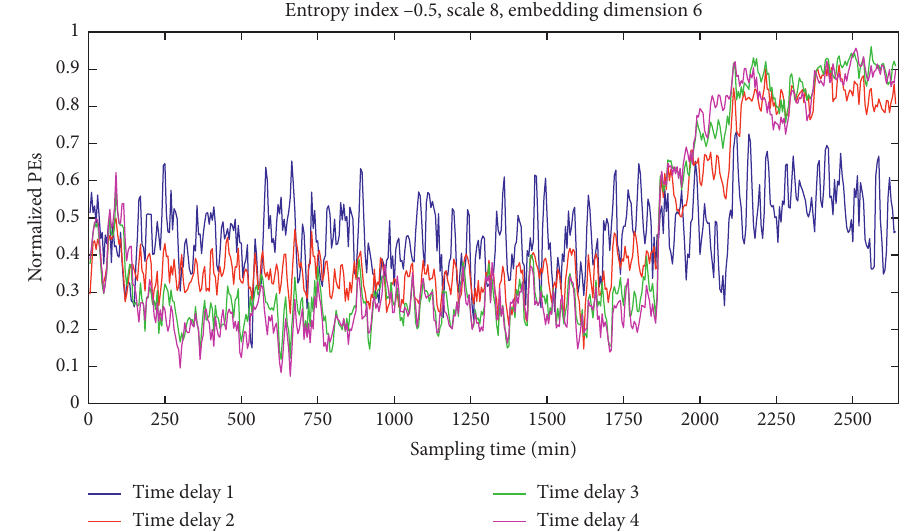
Figure 14: Results of health indicators on different time delays τ